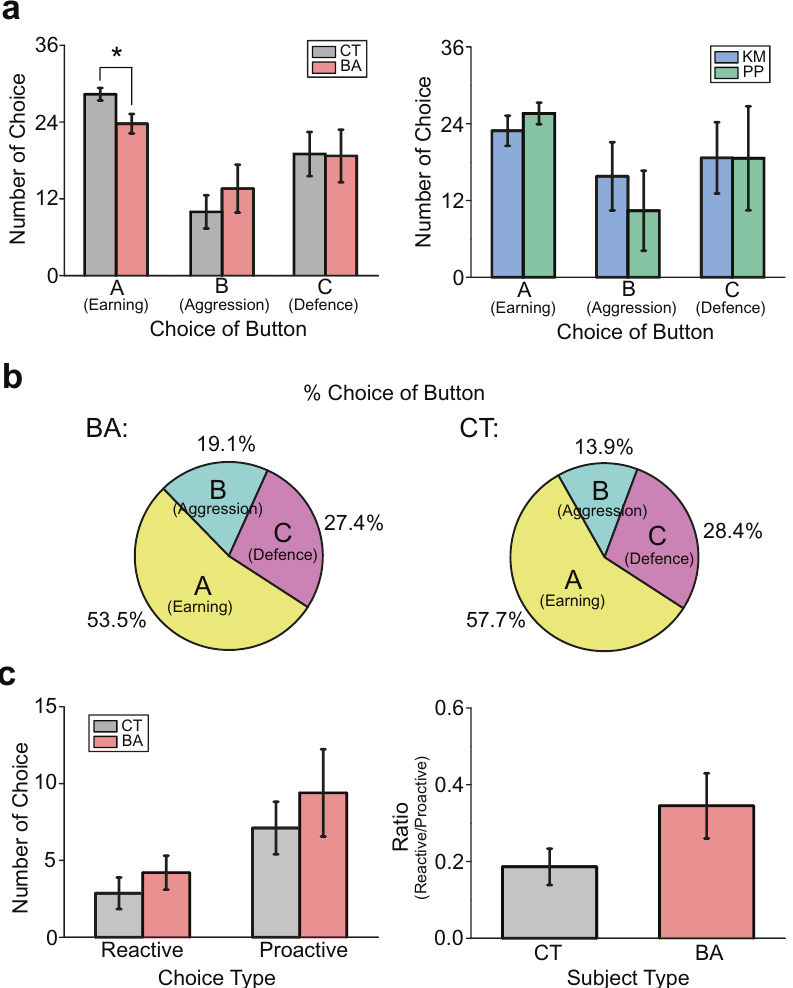
Fig. 1 Assessments of aggression with the PSAP test. a Bar graphs illustrating the number of choices for earning points (A button), attacking the opponent (B button), and protecting point subtractions (C button) in behavioural addiction (BA) patients and control (CT) subjects (left) as well as in kleptomania (KM) and paraphilia (PP) patients (right). Graphs show the means with error bars indicating s.e.m. * p < 0.05. b Pie charts illustrating percentages of choices for the A, B, and C buttons relative to the total choices in BA patients (left) and CT subjects (right). ( c ) Graphs showing the number of reactive and proactive aggression choices (left) and the ratio of reactive to proactive aggression choices (right) in BA patients and CT